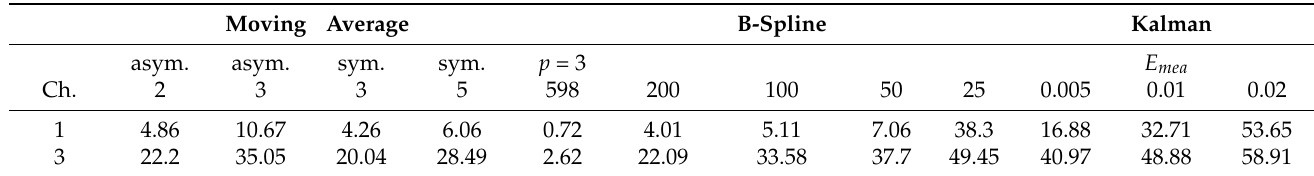
Table 6. The percentages of difference of the SM1 performance metric (100 × (SM1 0 − SM1 1 )/SM1 0 ) for moving average, B-spline, and Kalman filters for signals from channels 1 and 3 of the root-joint for the kicking model using various control parameters.